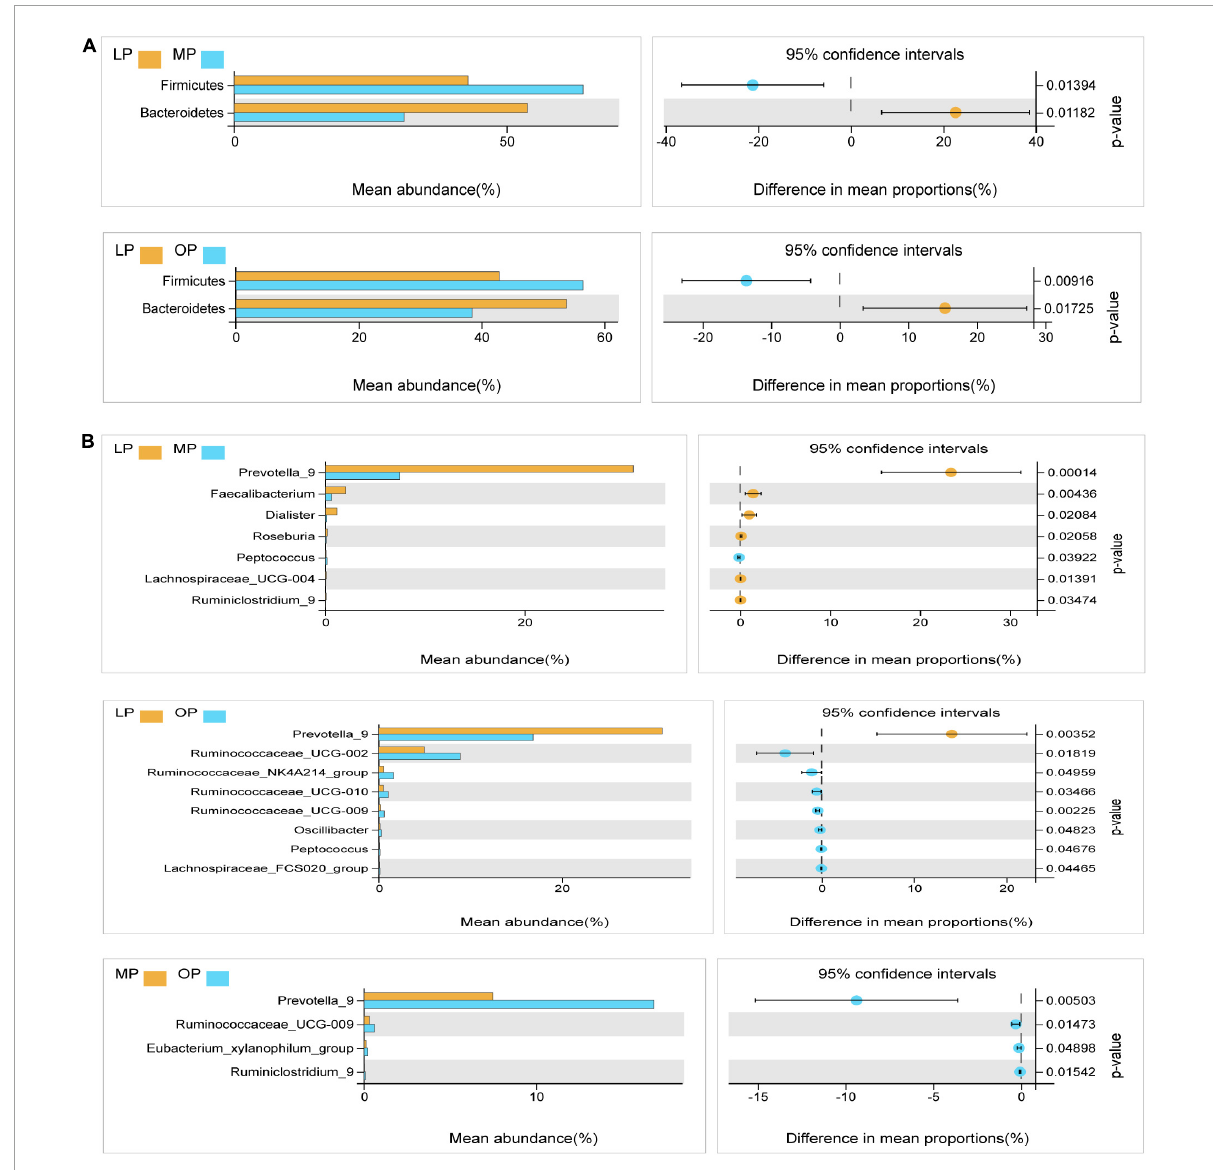
FIGURE3 Analysis of the microflora differences at the phylum levels at the respective stages of the menstrual cycle (A) . Analysis of the microflora differences at the genus levels at the respective stages of the menstrual cycle (B)